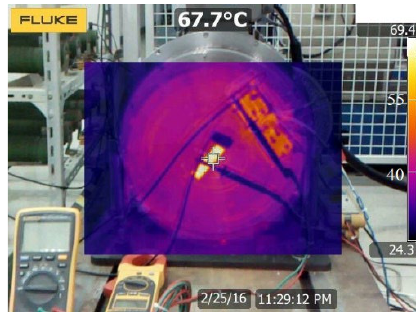
Figure 18. Schematic diagram of temperature when the excitation current is 1 A.